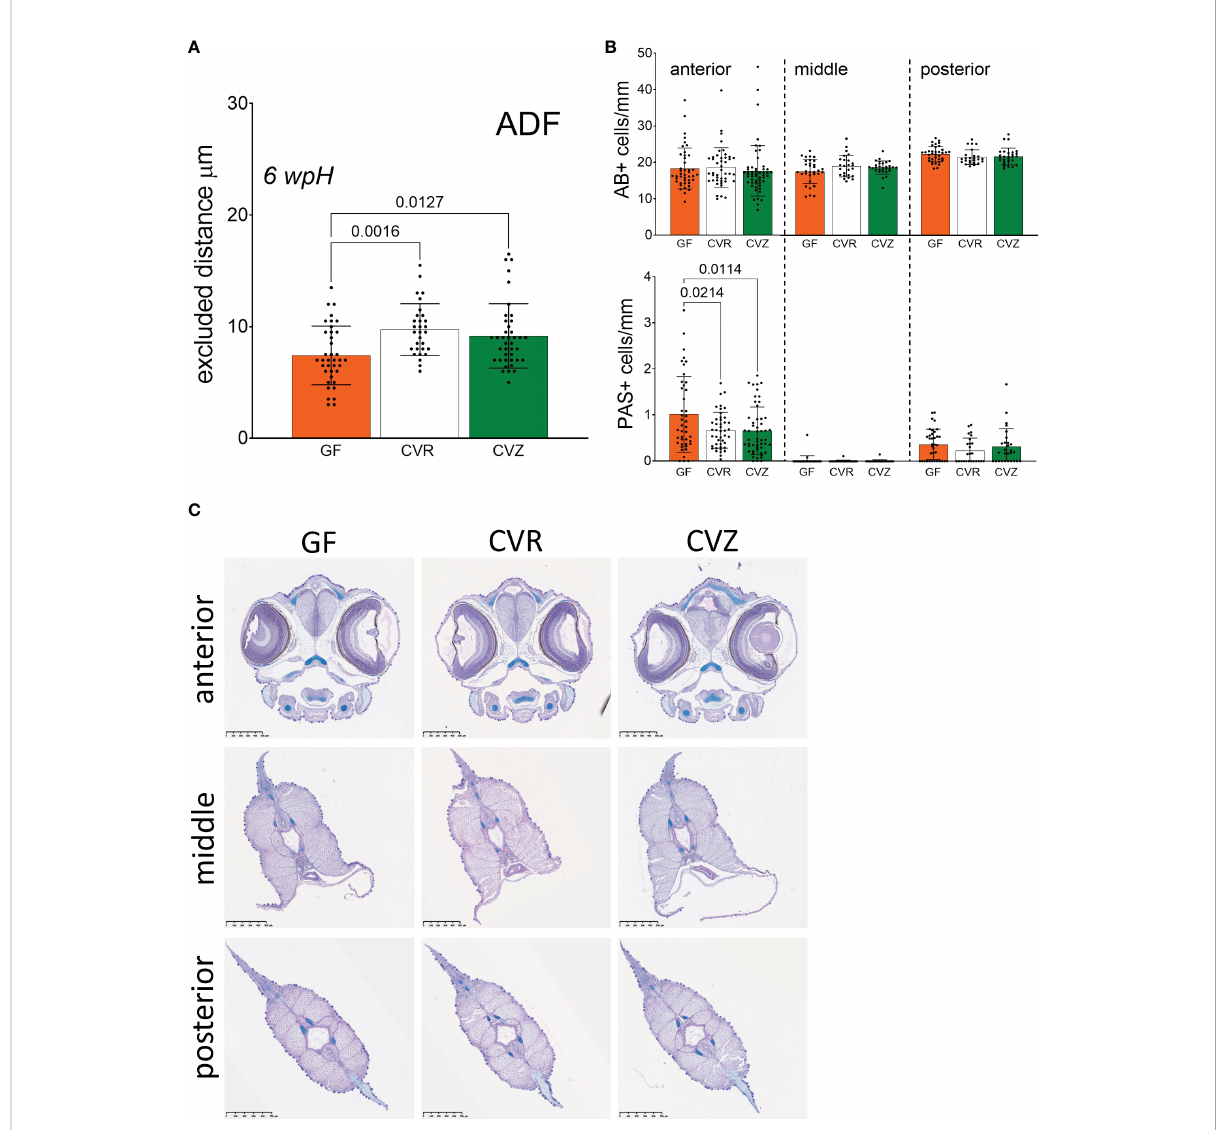
FIGURE 3 Use of the novel gnotobiotic system to study the microbial in fl uence on the skin mucosa of Atlantic salmon yolk sac fry (A) Estimated functional thickness of the mucus-like barrier at 6 wpH. Excluded distance between skin epithelial surface and 1 µm particles was measured in GF, CVR, and conventionalized (CVZ) fry. Measurements were taken at the body site anterior to the dorsal fi n (ADF). Bar graphs represent the mean excluded distance measured per bead ± SD. When possible, ten beads were measured per fry. Fry were raised in triplicate fl asks per condition. Three to four fry were sampled from a single replicate fl ask, thus a total of three to four fry per condition were measured. Means were compared to each other using one-way ANOVA and post-hoc Tukey ’ s multiple comparison tests. (B) Mucus cells per mm of yolk sac fry skin enumerated at 4 wpH after staining with Alcian blue (AB+) and periodic acid-Schiff (PAS+). Fry were raised in triplicate fl asks per condition. Two to three fry were sampled per replicate fl ask, thus a total of six fry per condition were processed for histology. Bar graphs represent the mean number of cells per mm of skin ± SD. Four to nine sections (see Methods) per fry were quanti fi ed per body segment (anterior, middle, and posterior, see Figure 1D). Means were compared to each other using one-way ANOVA and post-hoc Tukey ’ s multiple comparison tests. (C) Representative images of the stained sections corresponding to the three body segments examined and quanti fi ed in (B)